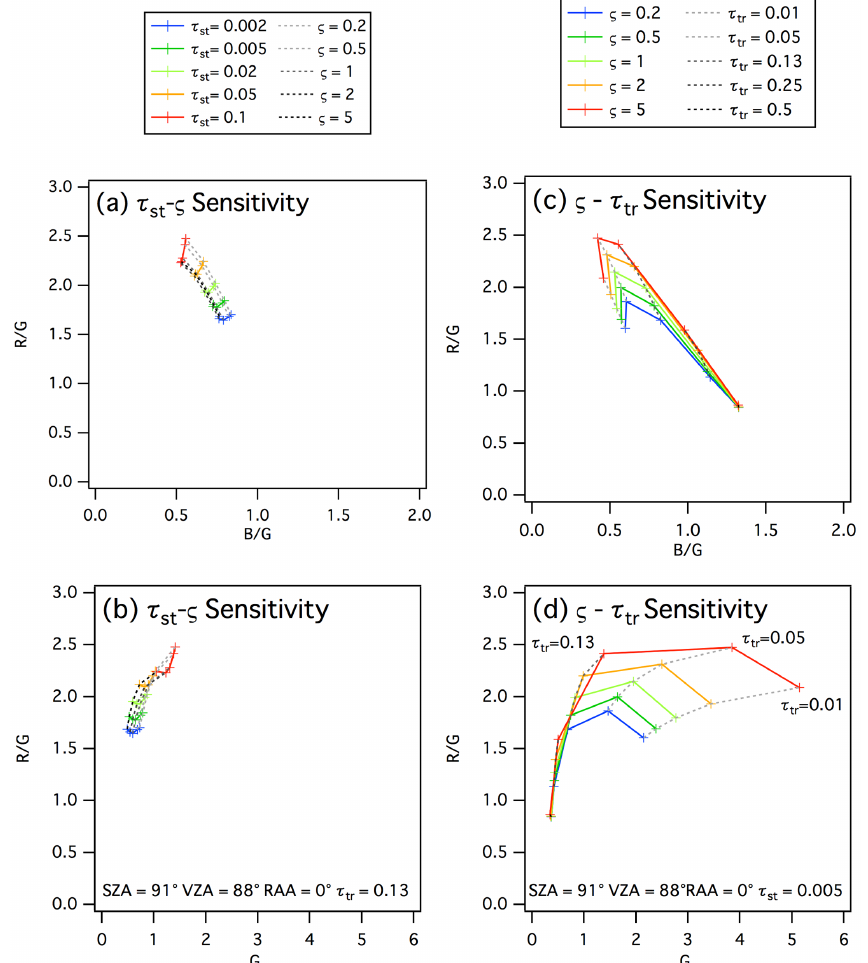
Figure 6. Sensitivity test results for color ratio values of the twilight sky near the horizon (VZA of 88 ◦ and SZA of 91 ◦ at the solar azimuth angle): (a, b) show the dependence of color ratio variations on the R / G–B / G cross section; (c, d) show the dependence of normalized brightness variations on the R / G– G n cross section. Dashed curves in the panels on the right (b, d) are isolines of tropospheric aerosol optical thickness, and solid curves are isolines of coarse–fine particle volume ratio. Dashed curves in the panels on the left (a, c) are isolines of coarse–fine particle volume ratio, and solid curves are isolines of stratospheric aerosol optical